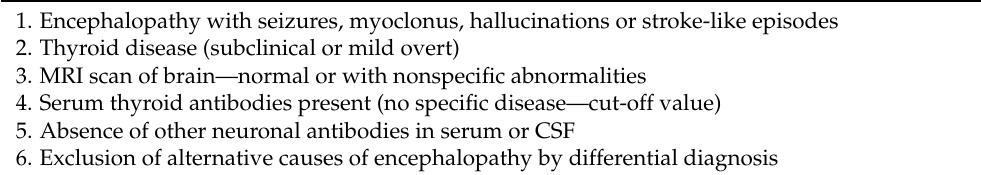
Table 2. Diagnostic criteria for Hashimoto encephalopathy (based on Graus et al.